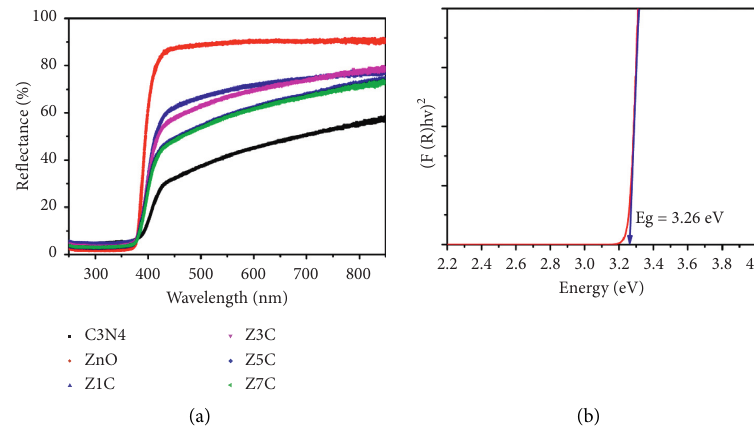
Figure 4: Reflectance spectra of g-C [F(R) ∗ h ] ] 1/2 versus h ] as shown in Figure S2 for g-C g-C N @ZnO. The optical bandgap of the pure g-C 3 4